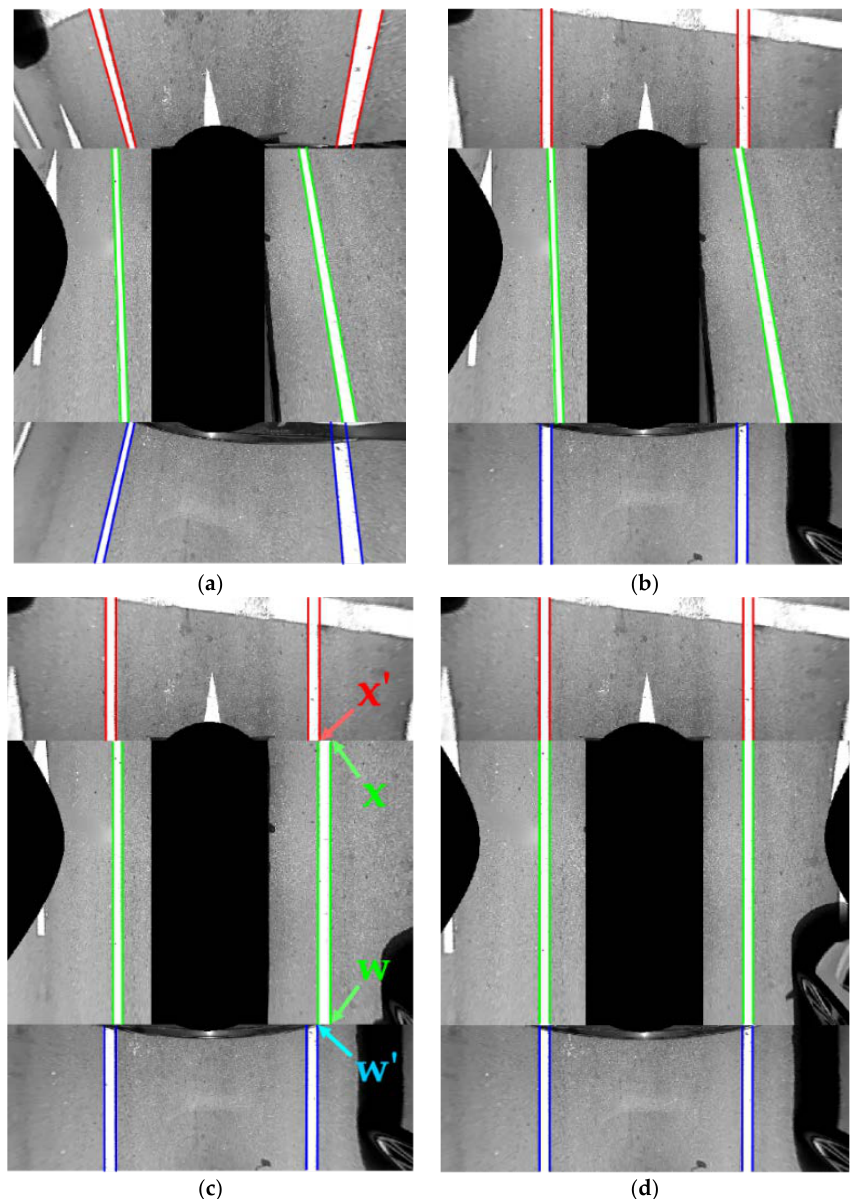
Figure 11. Resulting AVM images at consecutive calibration stages. ( a ) Before the calibration; ( b ) After calibrating the front and rear cameras; ( c ) After estimating the yaw and roll angles of two side cameras; ( d ) After calibrating all pitch, yaw, roll angles of four cameras. Red, blue, and green lines indicate the lane markings in the front, rear, and side cameras, respectively.